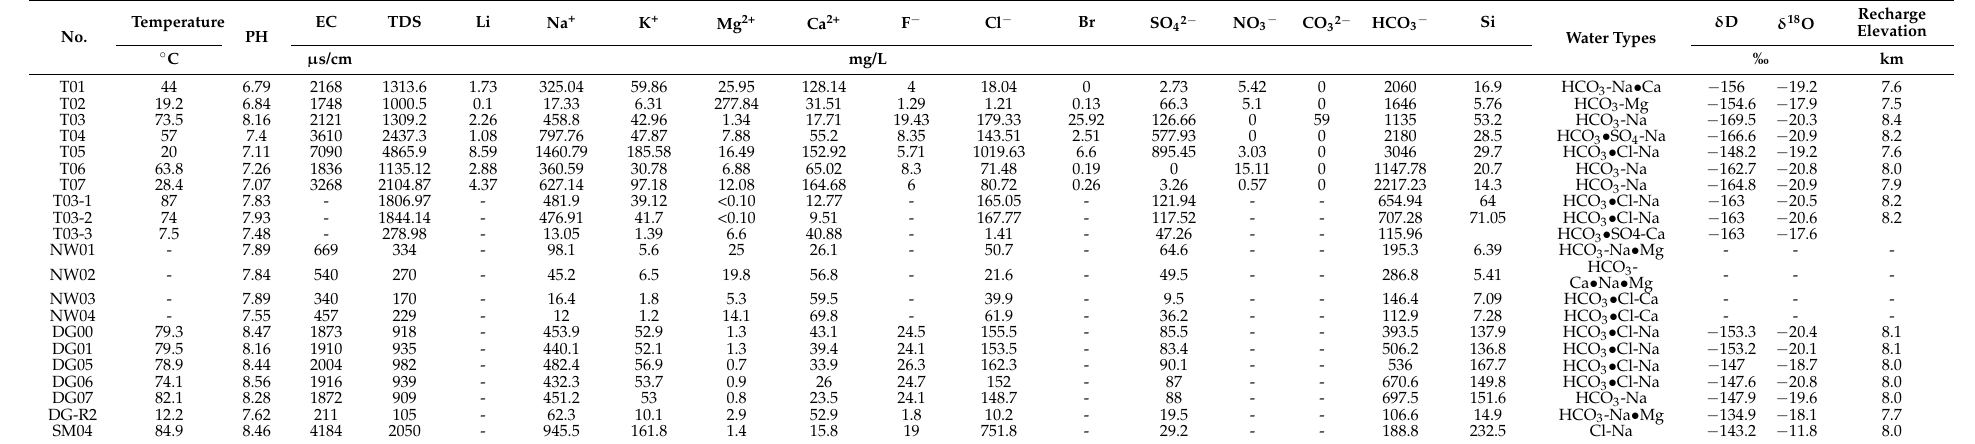
Table 2. Spring samples’ chemical composition along the